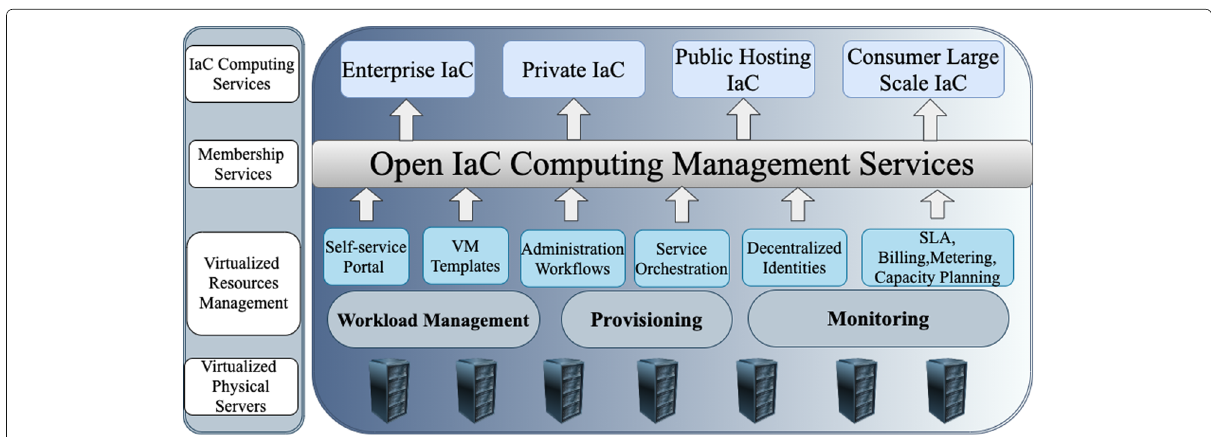
Fig. 1 Computing Management Services and resource management in an IaC